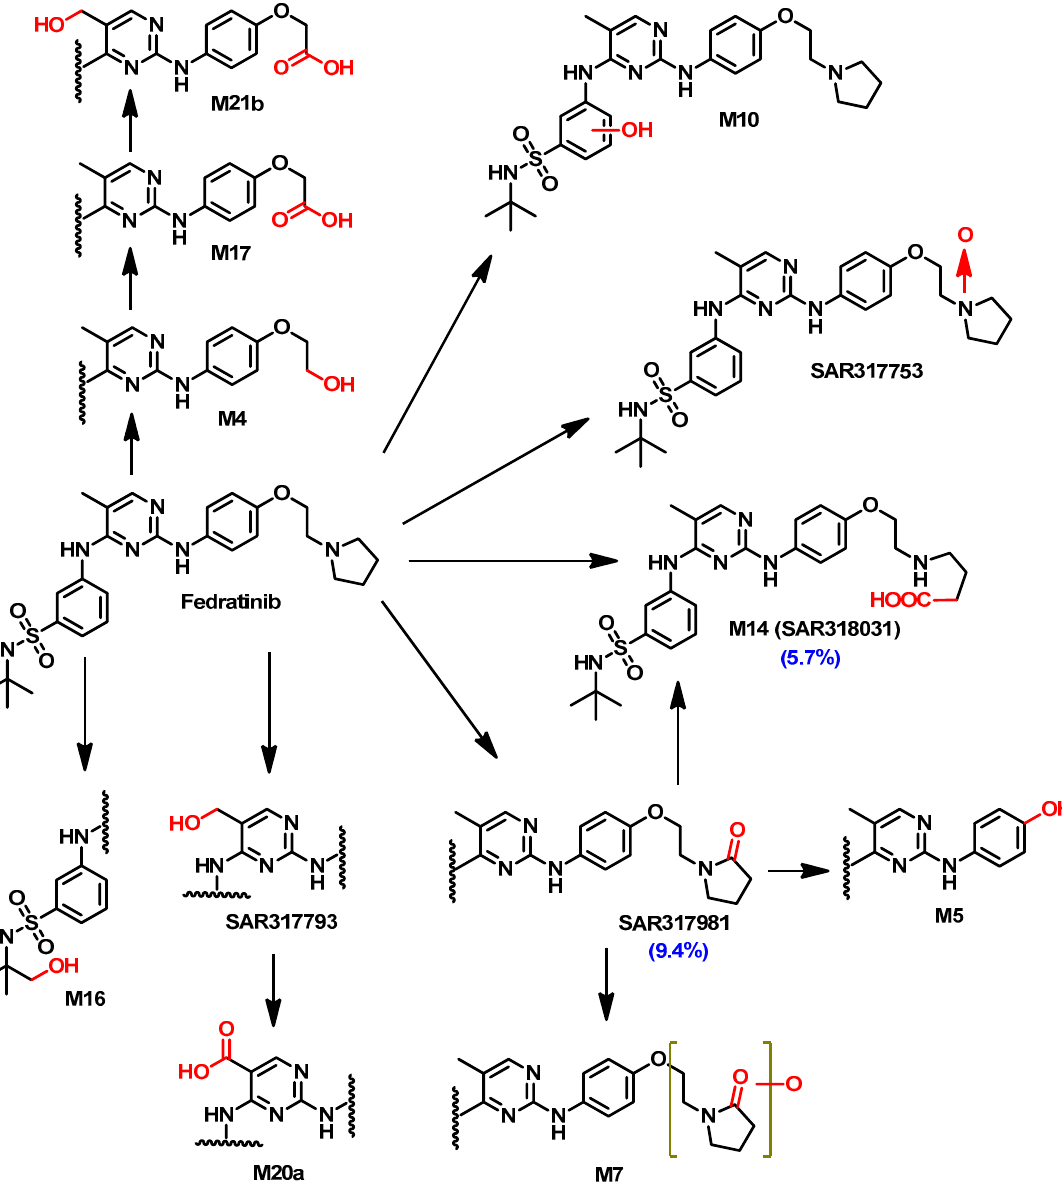
Figure 31. Proposed metabolic pathway and metabolites of fedratinib in humans.